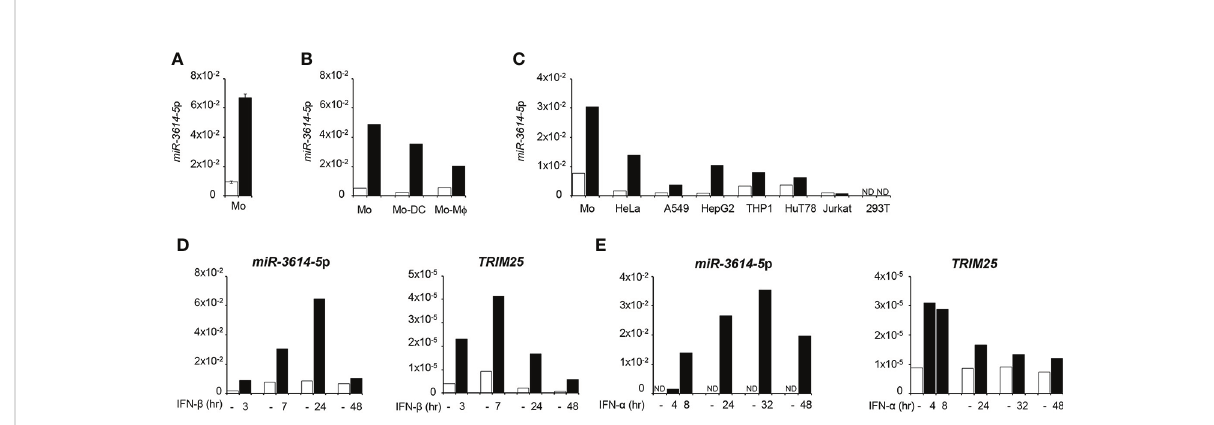
FIGURE 1 MiR-3614-5p is induced by type I IFN. (A) MiR-3614-5p expression in monocytes puri fi ed from two healthy donors and treated with 100pM IFN- b for 24 hr (black) or not treated (white). Results are shown as expression (2 - D Ct ) relative to U6 used as housekeeping gene. Values are means ± SEM. (B) Mir-3614-5p expression in monocytes from one donor and in derived macrophages (Mo-M f ) and dendritic cells (Mo-DC). IFN- b stimulation and results as in A). (C) Mir-3614-5p expression in different human cell lines and in primary monocytes from a single donor (Mo). Stimulation with IFN- a (100pM) for 8 hr. Data are representative of two independent experiments. ND, not detected. (D) MiR-3614-5p (left panel) and TRIM25 (right panel) levels measured in primary monocytes stimulated with IFN- b (100pM) as indicated. Results for TRIM25 are shown as expression (2 - D Ct ) relative to 18S . Data are representative of two independent experiments. (E) MiR-3614-5p (left panel) and TRIM25 (right panel) levels measured in HeLa cells stimulated with IFN- a (100pM) for the indicated times. Results expressed as in D). Data are representative offour independent